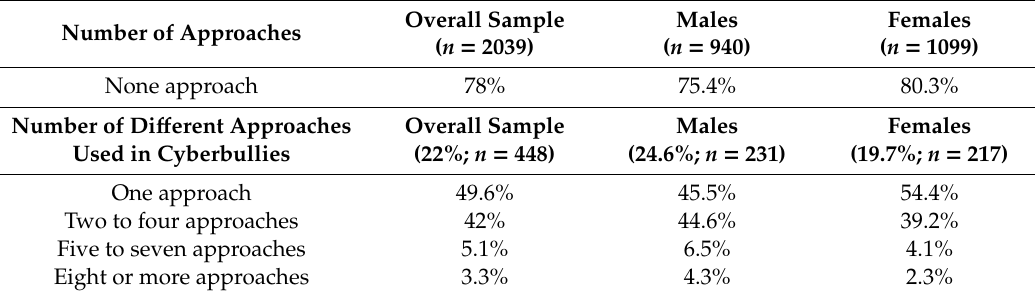
Table 1. Frequencies of cyberbullying perpetration behaviors in the last two